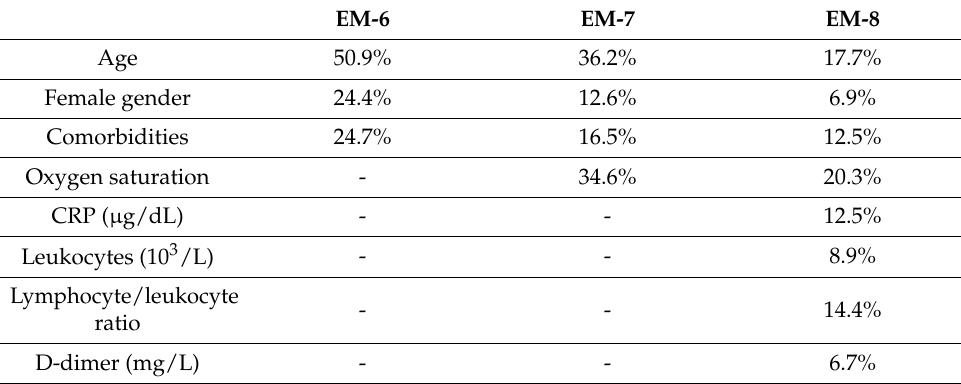
Table 7. Relative importance of the variables in the total cohort of COVID-19 patients analyzed using a new methodology for model interpretation suggested by Lundeberg and Lee [16,17]: SHAP (SHapley Additive ExPlanation)